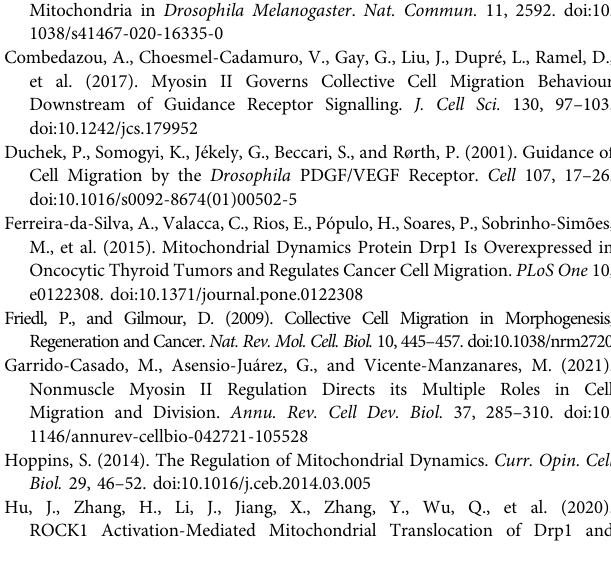
Supplementary Table S1 | Primers used in this